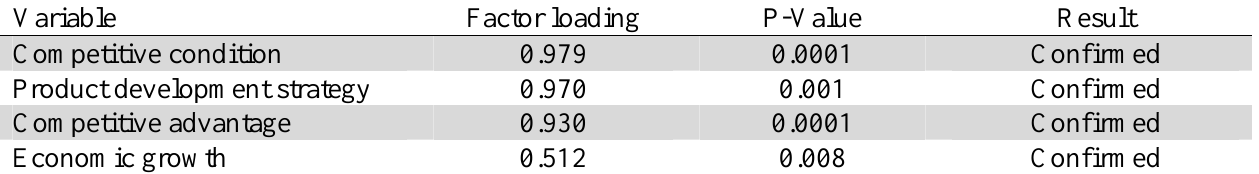
The results of testing the effects of various factors on purchase